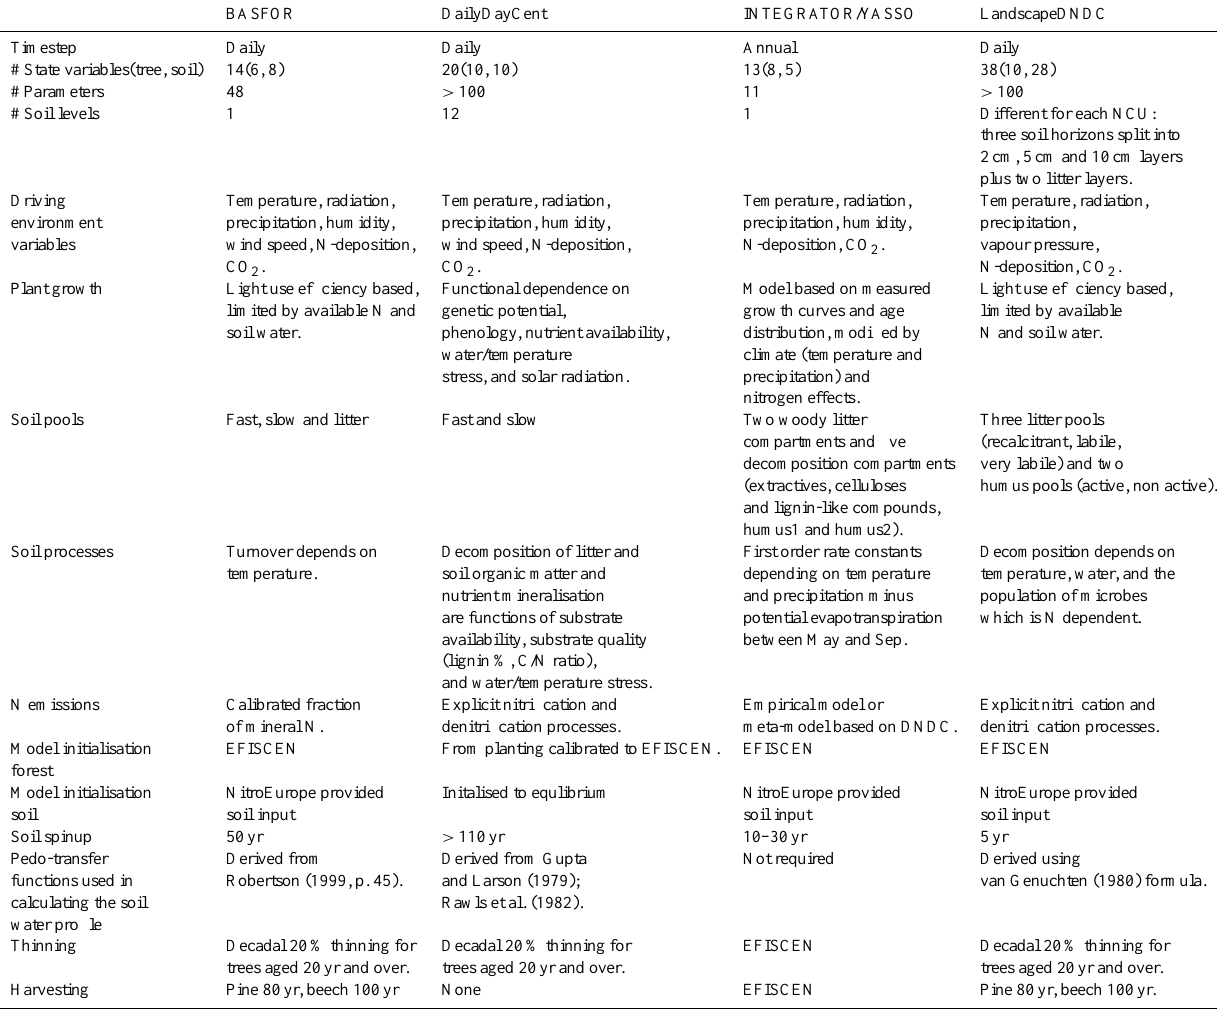
Table 1. Characteristics of the four models used in this study.